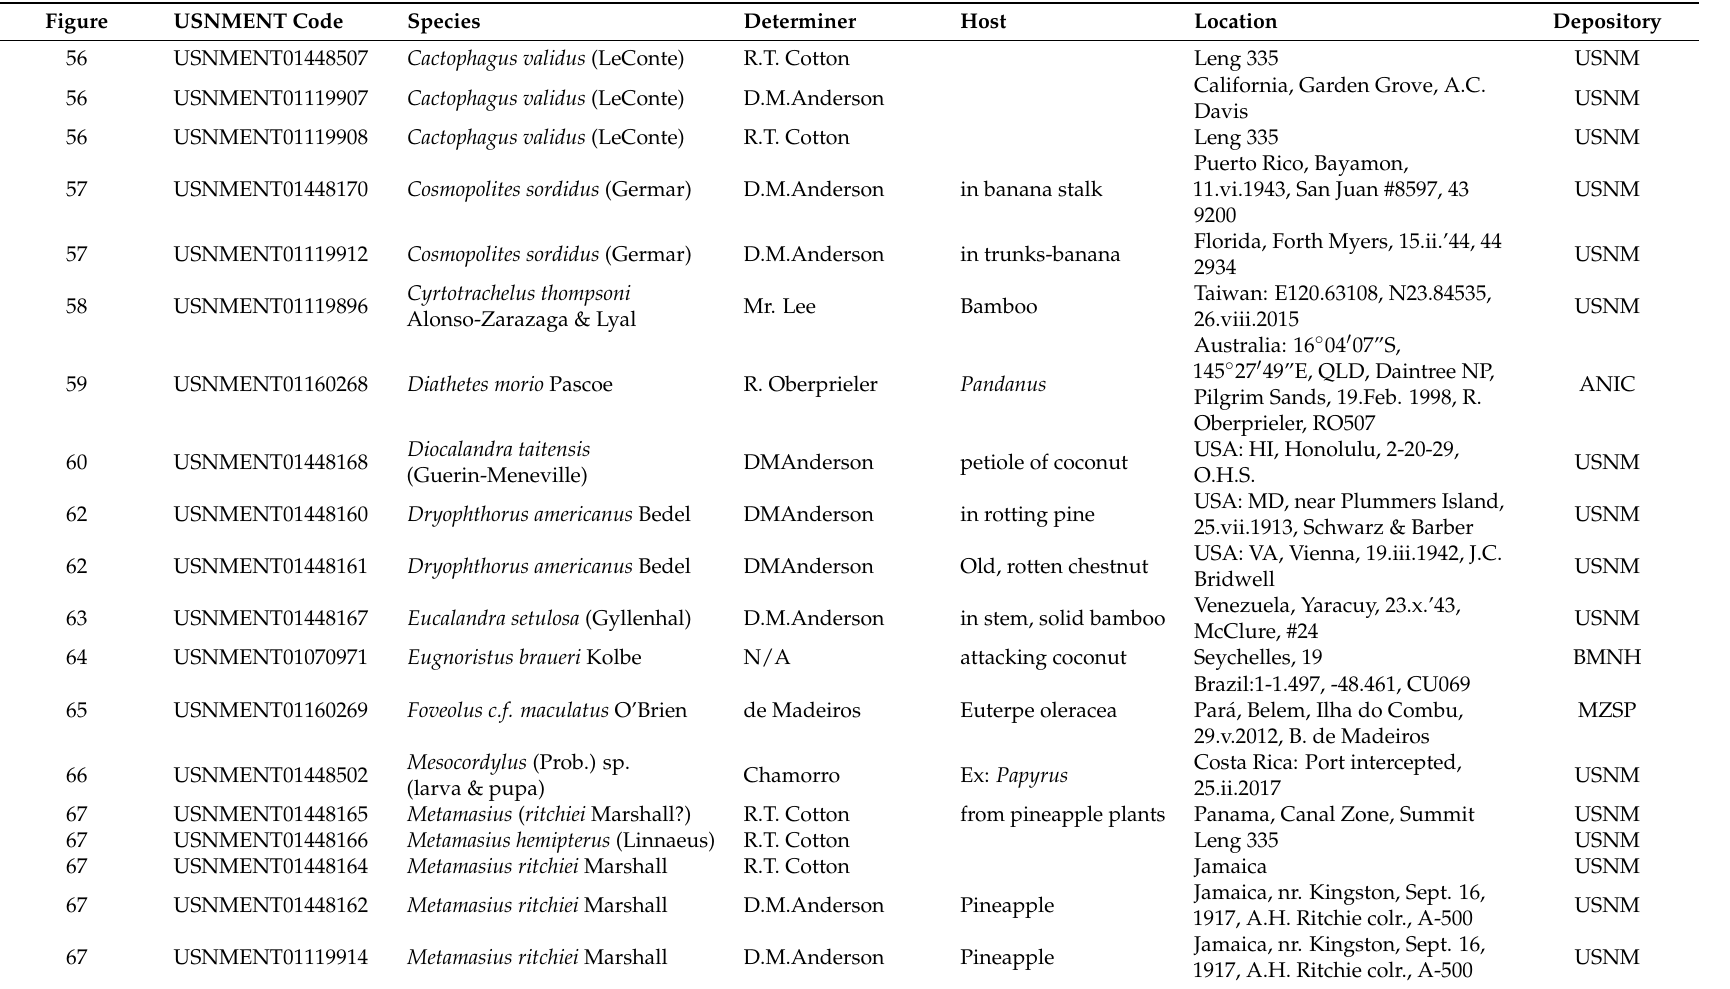
Table 2. Material examined including locality data and